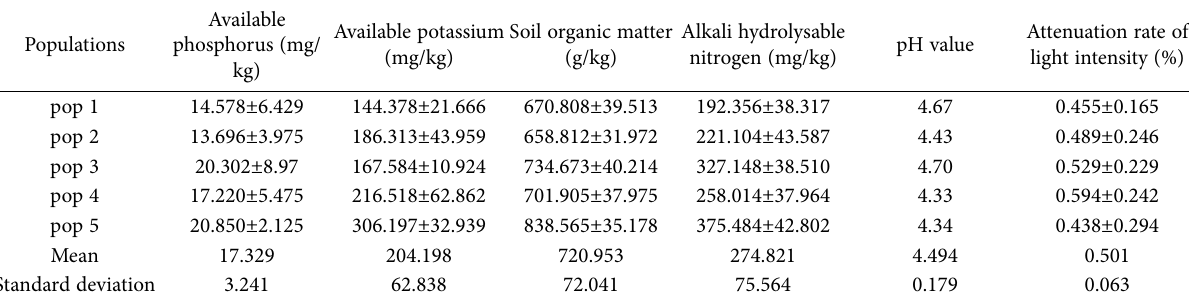
Table 6 Contents of available phosphorus, available potassium, alkali hydrolysable nitrogen, soil organic matter, and the pH values of five sampling spots.